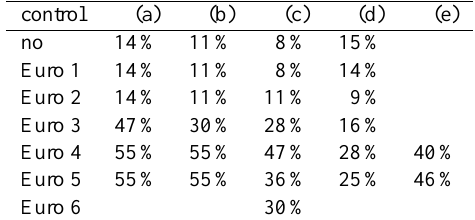
Table 1. Primary NO 2 emission shares in the literature. (a) Sjödin and Jerksjö (2008); (b) Grice et al. (2009); (c) HBEFA 3.1 (2010); (d) Carslaw and Rhys-Tyler (2013); (e) Weiss et al. (2011). (c) is used in GAINS.